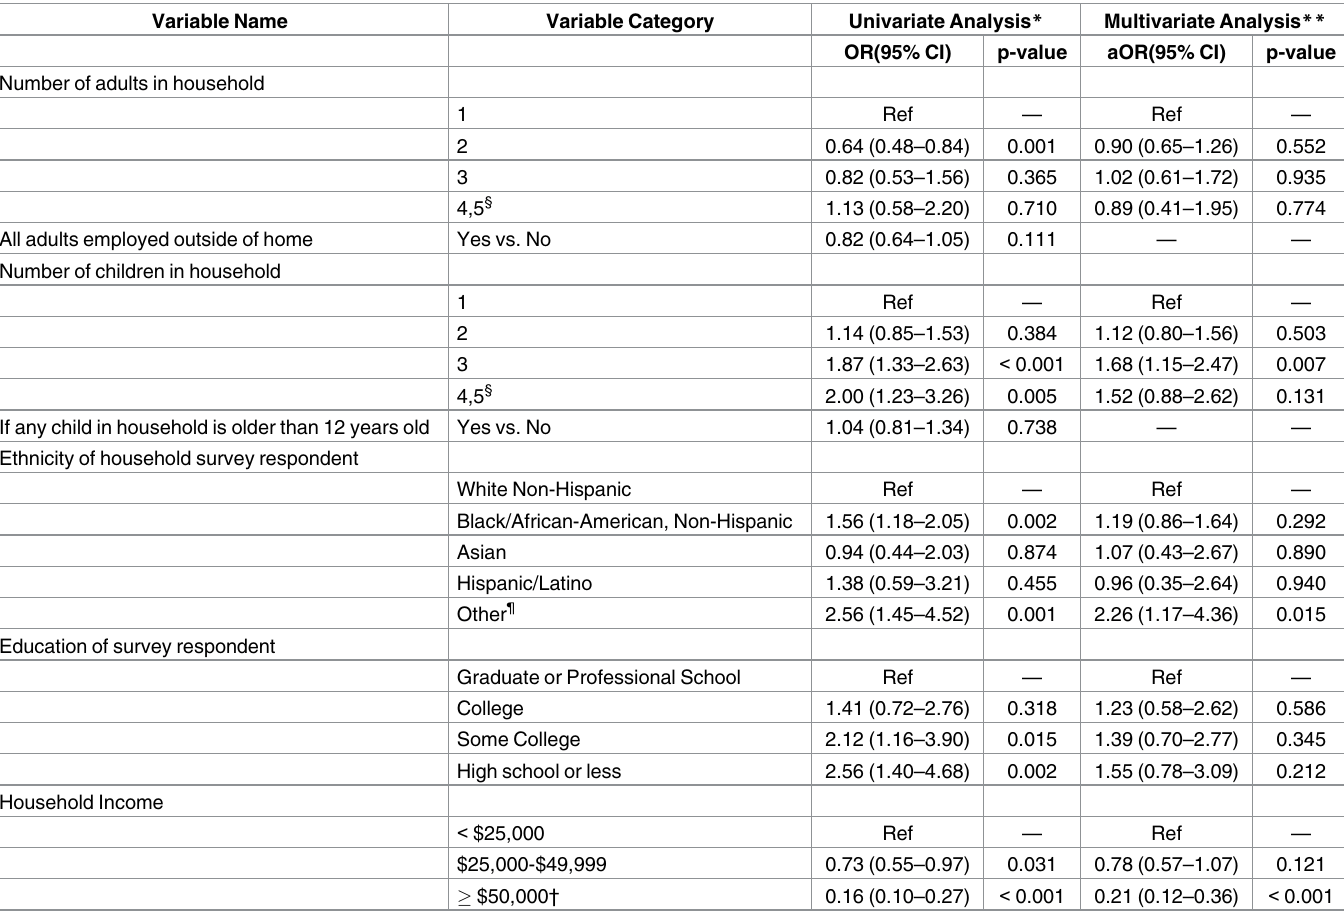
Table 3. Factors associated with difficulty providing food due to lost accessto subsidized school lunches during unplanned school closure. Har- rison County SchoolDistrict, Mississippi, August